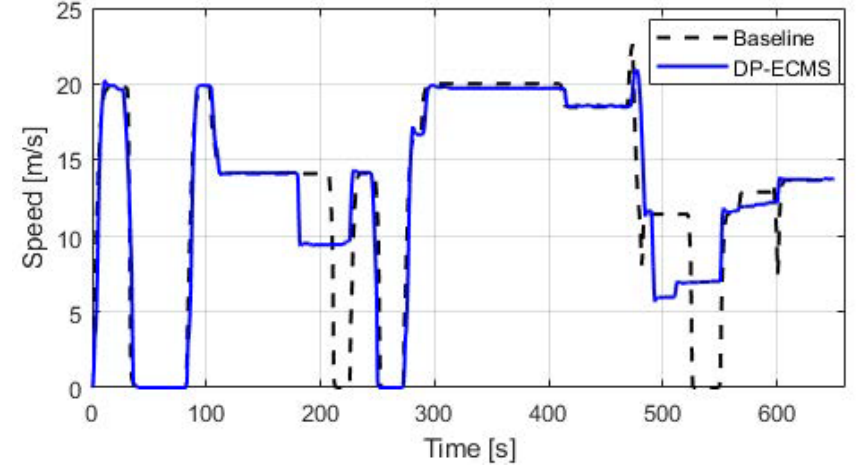
Figure 8. Speed profiles of DP-ECMS vs. baseline.